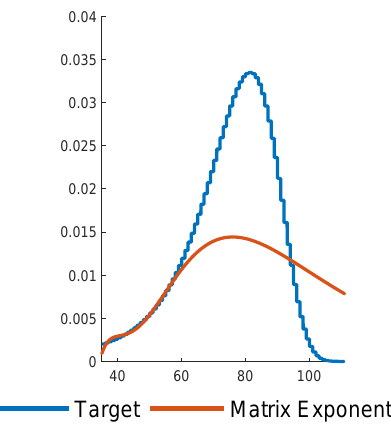
Figure A1. Sum-of-exponentials fits in age range